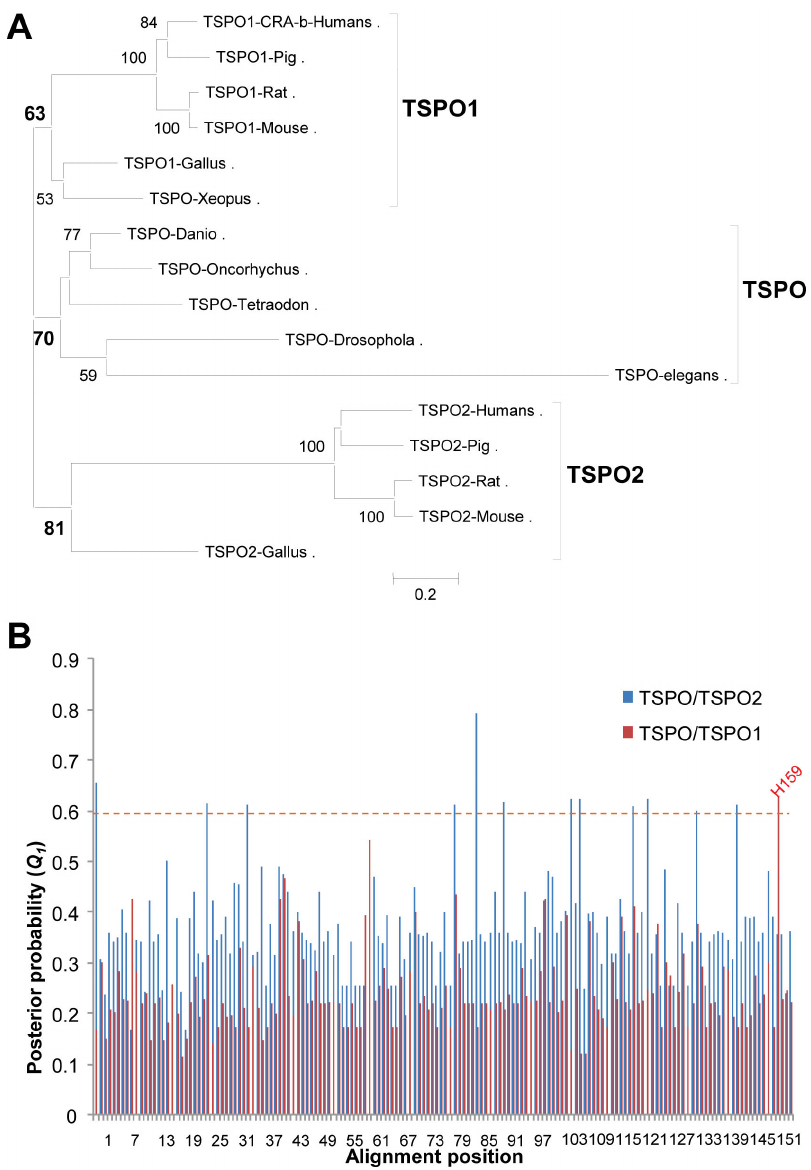
Figure 2. Functional divergence analysis of TSPOs before and after gene duplication. A. NJ-tree of TSPOs from human to worm. The evolutionary history was inferred using the Neighbor-Joining method [97]. The percentage of replicate trees in which the associated taxa clustered together in the bootstrap test (1000 replicates) is shown next to the branches. The tree is drawn to scale with branch lengths in the same units as those of the evolutionary distances used to infer the phylogenetic tree. The evolutionary distances were computed using the Dayhoff matrix-based method and are given in the units of the number of amino acid substitutions per site. All positions containing alignment gaps and missing data were eliminated only in pairwise sequence comparisons (pairwise deletion option). A total of 187 positions were analyzed in the final dataset. Phylogenetic analyses were conducted in MEGA4 [27]. The following sequences with accession numbers were used for the analysis: TSPO-Danio